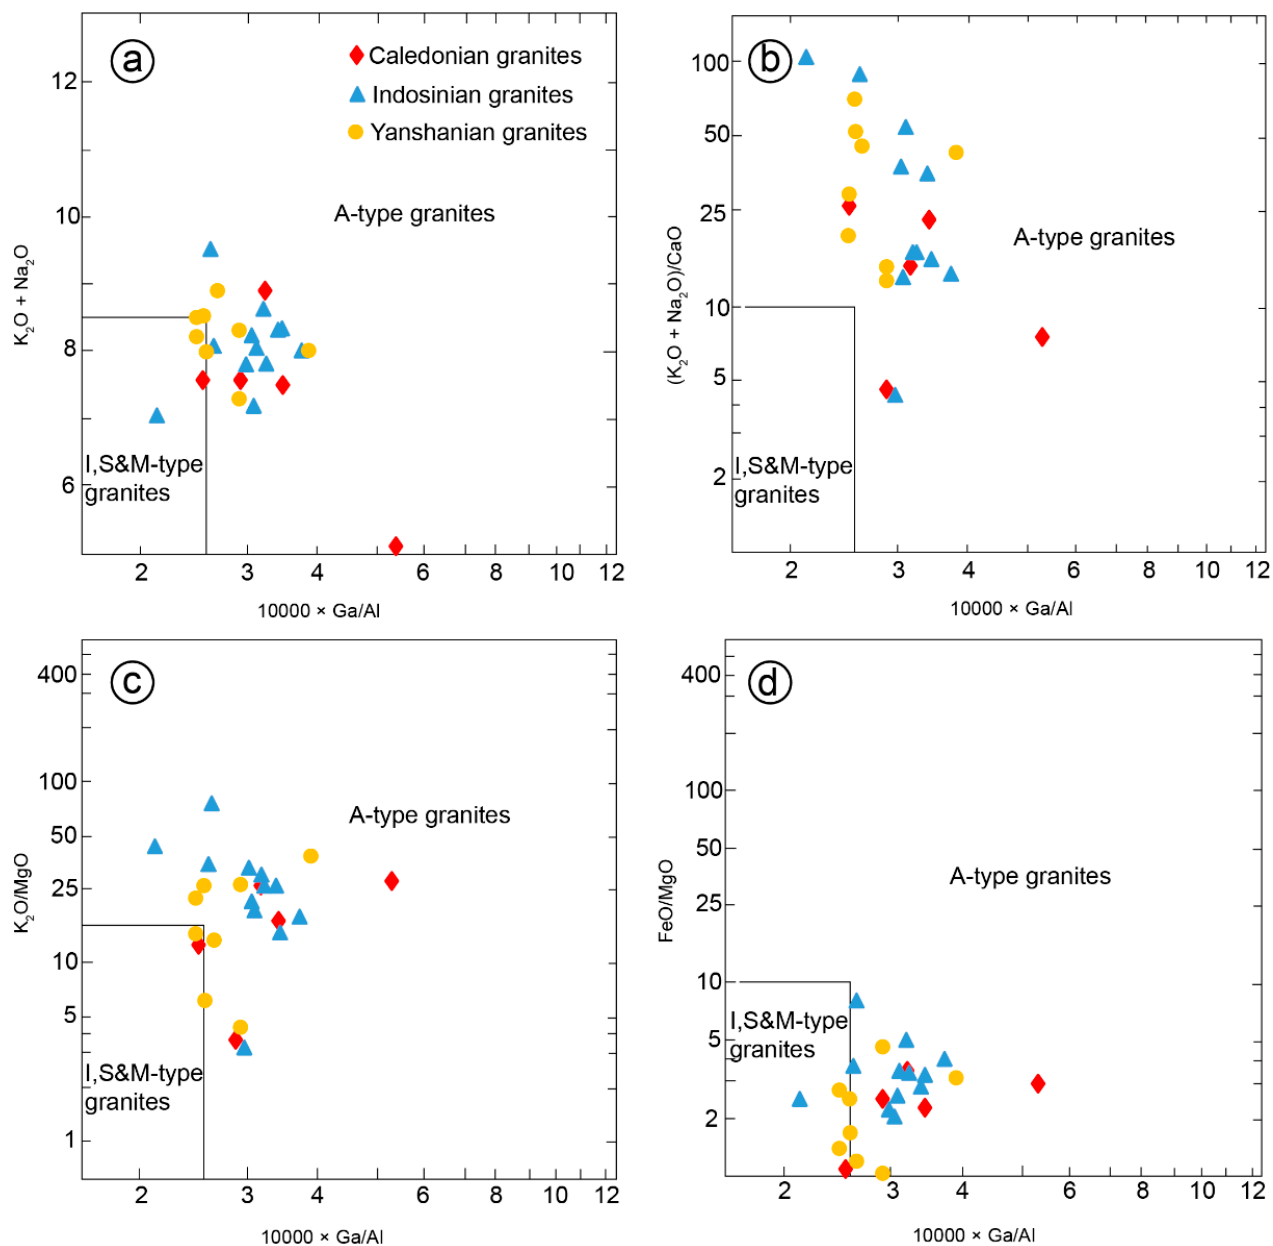
Figure 16. 10,000 × Ga/Al versus K 2 O + Na 2 O ( a ), (K 2 O + Na 2 O)/CaO ( b ), K 2 O/MgO ( c ) and FeO/MgO ( d ) plots of various granites from the Taoxi dome. Diagrams are from Whalen et al. (1987) [44].